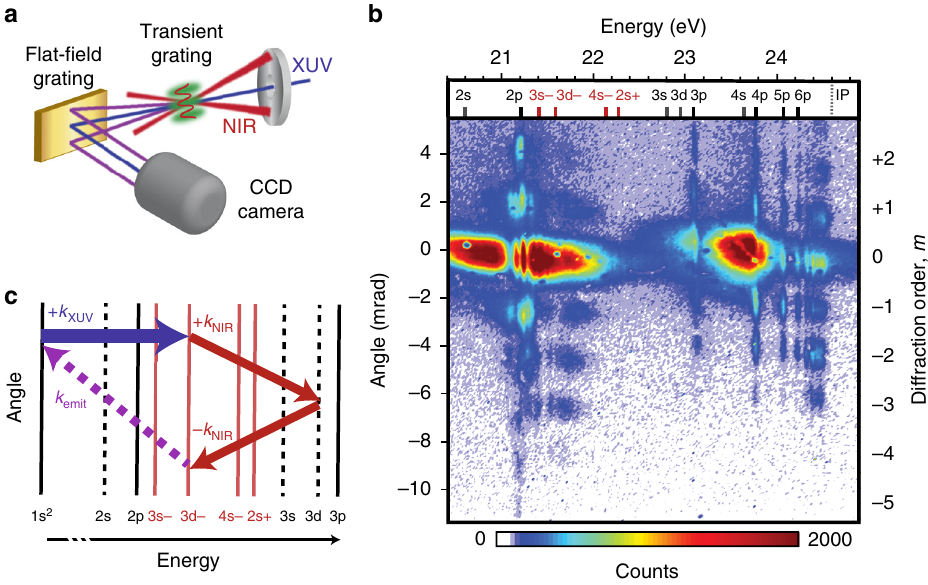
Fig. 1 Experimental characterization and demonstration of extreme ultraviolet (XUV) transient grating spectroscopy. a Simpli fi ed experimental set-up depicting the formation of a transient grating in the helium sample (green) and the spectrometer employed to image the diffracted signals as a function of the delay between an subfemtosecond XUV pulse train and two few-cycle, time-coincident near-infrared (NIR) pulses. b A charge-coupled device (CCD) camera image taken 3.5 fs after pulse overlap. Positive delays indicate that the XUV pulse precedes the NIR grating. A number indicating the diffraction order, m , is provided to the right of the fi gure. Resonances and light-induced states (LISs) are assigned at the top of the image. c Energy level schematic depicting the three-photon pathway that emits at the energy of the LIS in the fi rst grating order. Solid black lines correspond to np bright states, dashed lines correspond to ns or nd dark states, and solid red lines correspond to